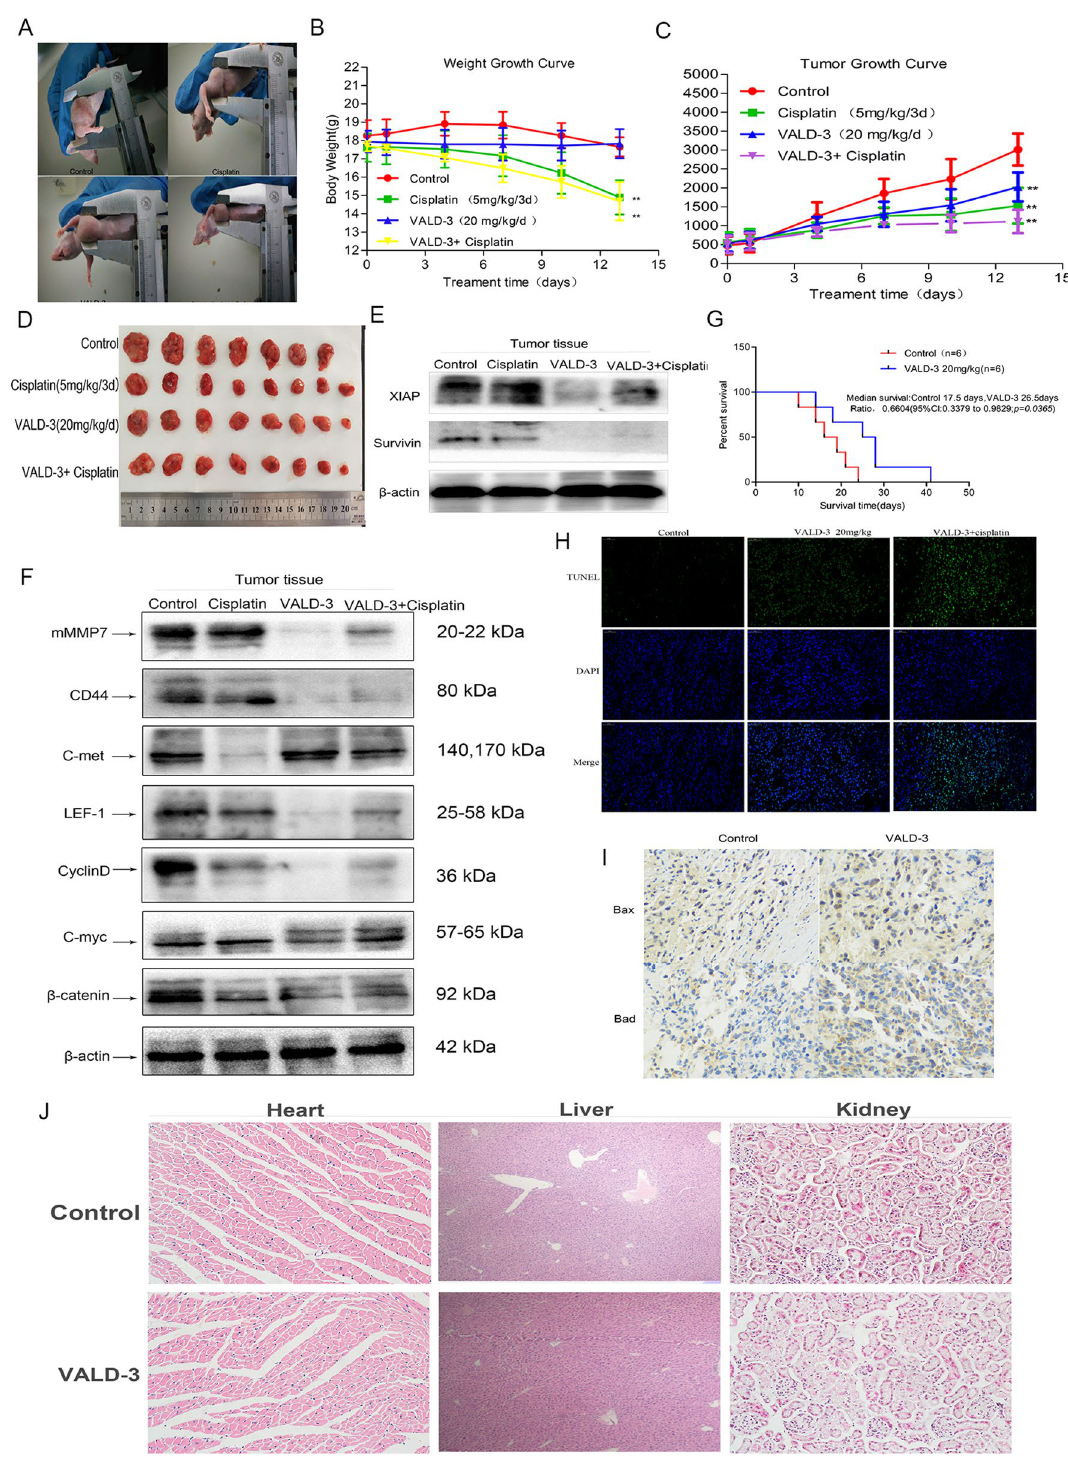
Figure 7. Effects of VALD-3 on the anti-tumor in vivo. ( A ) Tumor formation in nude mice. ( B ) Body weight were measured every 3 days. ( C ) Tumor volume variation, ** p < 0.05 versus control group. Each point represents the mean ± SD. ( D ) Representative images of MCF-7 xenograft tumors isolated from the control group, cisplatin (5 mg/kg/3d), VALD-3-treated groups and VALD-3 + cisplatin-treated group after treatment for 13 days. ( E ) Western blotting were performed to analyze the expression levels of Wnt/β-catenin pathway and its downstream molecules and ( F ) the expression levels of Surviving and XIAP in tumor tissues. ( G ) Survival analysis curve. ( H ) The apoptotic levels of human breast tumor tissues were measured by TdT-mediated dUTP-biotin nick end labeling (TUNEL) staining. ( I ) Immunohistochemical analysis of Bad and BAX in tumor tissues. Pretreatment with VALD-3. ( J ) HE staining of tumor specimens and major organs. Scale bars = 100